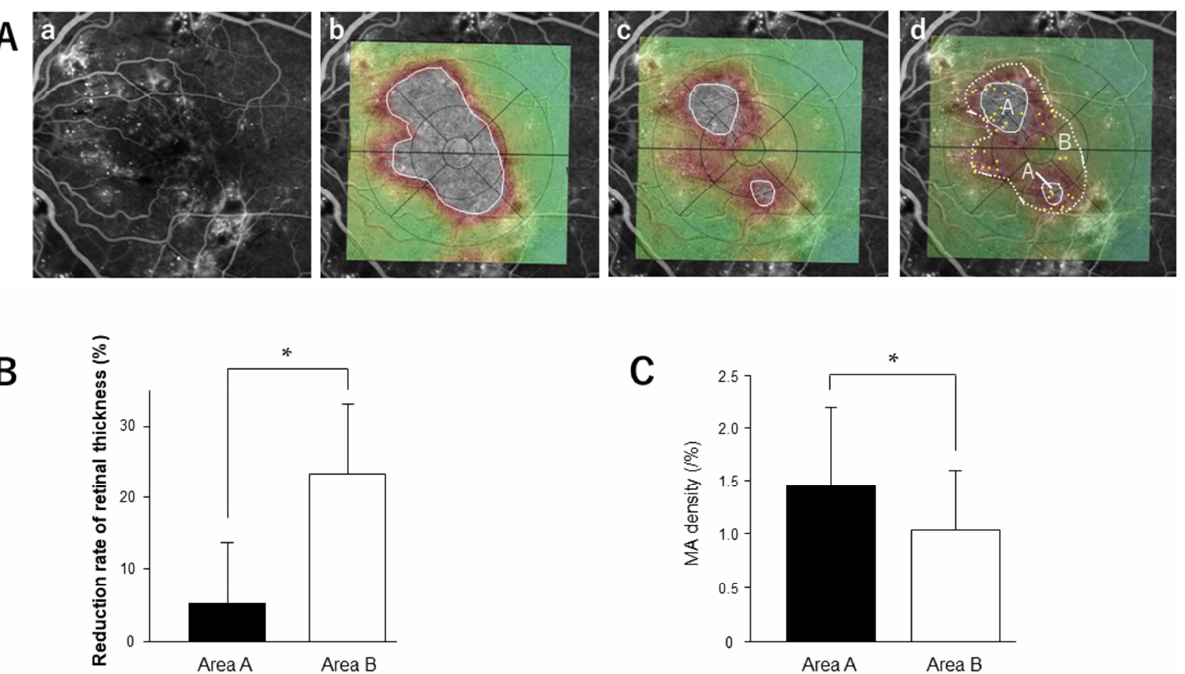
Figure 4. MA density and reduction rate of retinal thickness in the residual edema after anti-VEGF treatment. ( A ) Representative merged image. Fluorescein angiography images taken before injection ( a ) were merged with the OCT maps taken before ( b ) and 1 month after injection ( c ). The severely edematous area (>500 µ m) is outlined by a white line. The MA is marked in the merged image ( d ). A: Residual edema area; B: edema absorption area. ( B ) Comparison of the reduction rate of retinal thickness between the residual edema and the edema-absorbed area. Area A: Residual edema; Area B: edema absorption area. Data represent mean ± standard deviation (SD). * p < 0.05. ( C ) Comparison of MA density between the residual edema and edema-absorbed area. Area A: Residual edema; Area B: edema absorption area. Data represent mean ± standard deviation (SD). * p < 0.05. MA, microaneurysms.